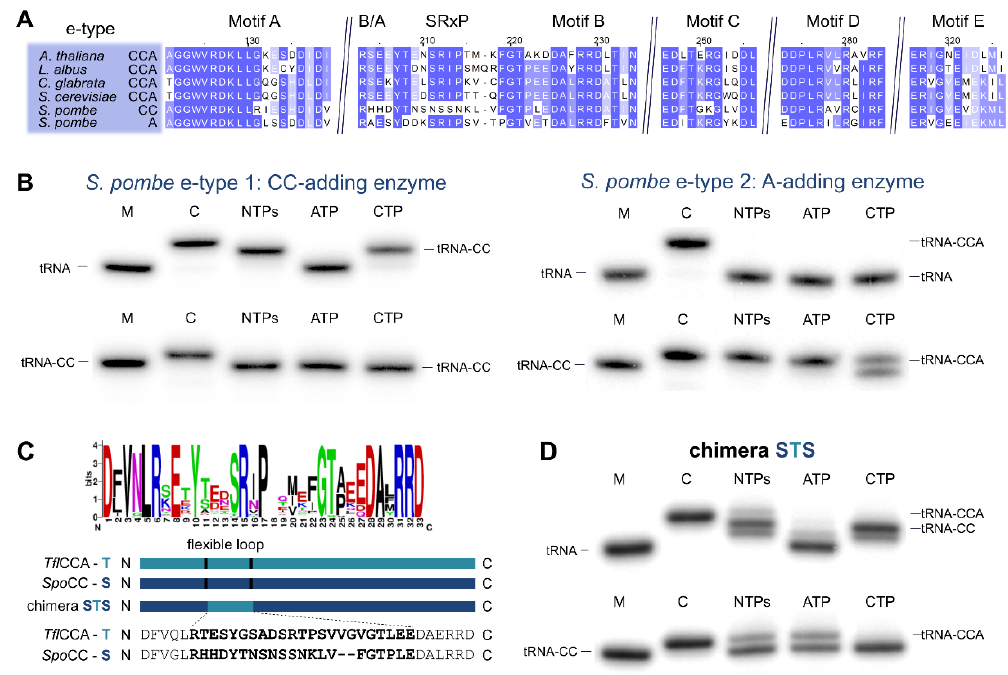
Figure 5. S. pombe performs CCA-addition with collaborating CC-and A-adding enzymes. ( A ) Alignment of the catalytic core of both S. pombe e-type enzymes with sequences of tested e-type CCA-adding enzymes of A. thaliana (accession number (AC): Q94K06; [47]), L. albus (AC: AAB03077.1; [48]), C. glabrata (AC: XP_449283.1; [46]), and S. cerevisiae (AC: P21269; [49]). Highly conserved residues are indicated in blue. Similar to the S. rosetta counterpart, the S. pombe CC-adding enzyme shows strong deviations from the conserved flexible loop sequence responsible for its functional restriction. ( B ) Both enzymes were incubated with labeled substrates tRNA Phe (top) or tRNA Phe -CC (bottom). The e-type enzyme 1 (left) exclusively adds two C residues on tRNA Phe but does not accept tRNA Phe -CC for A-addition and therefore represents a CC-adding enzyme. The e-type enzyme 2, on the other hand, accepts only tRNA Phe -CC as a substrate and adds just a terminal A residue and is therefore identified as an A-adding enzyme. Similar to the S. rosetta enzyme (Figure 4B), this enzyme misincorporates an additional C residue if CTP only is offered. Taken together, these enzymes represent typical CC-and A-adding enzymes. ( C ) In the CC-adding enzyme, the flexible loop is lacking the conserved sequence “Yxxx(x)SRxP” found in eukaryotic e-type CCA-adding enzymes. For construction of an enzyme chimera carrying the flexible loop and the B/A motif of a closely related fungal CCA-adding enzyme, the corresponding sequence of T. flavorubra (T) was inserted into the CC-adding enzyme of S. pombe (S), generating the chimera STS (S, S. pombe CC-adding enzyme N-terminus; T, flexible loop of T. flavorubra CCA-adding enzyme; S , S. pombe CC-adding enzyme C-terminus). ( D ) On tRNA Phe lacking the 3’-CCA terminus, chimera STS incorporates three nucleotides. While the addition of the terminal residue is not very efficient, one has to consider that the inserted regions in a chimeric protein are not perfectly adjusted to the context of the host protein. Hence, wild type-like activity cannot be expected. On tRNA Phe -CC, the chimera efficiently adds a terminal A residue, clearly demonstrating that A- addition is restored to a considerable extent. M, mock incubation of the tRNA in the absence of enzymes; C, control tRNA Phe with CCA end as size marker. 3. Discussion 3.1. Restricted Activities for CC- and A-Addition Are Widely Distributed in Bacteria as Well as in Eukaryotes While bacterial tRNA nucleotidyltransferases can be divided into different functional subclasses (CCA-, CC- and A-, and CCAIIa-adding enzymes) [10,11,22,28,29,32], the existence of CC- and A- adding enzymes in a single eukaryotic species ( S. pombe ) was reported only recently [37,38]. Yet, our